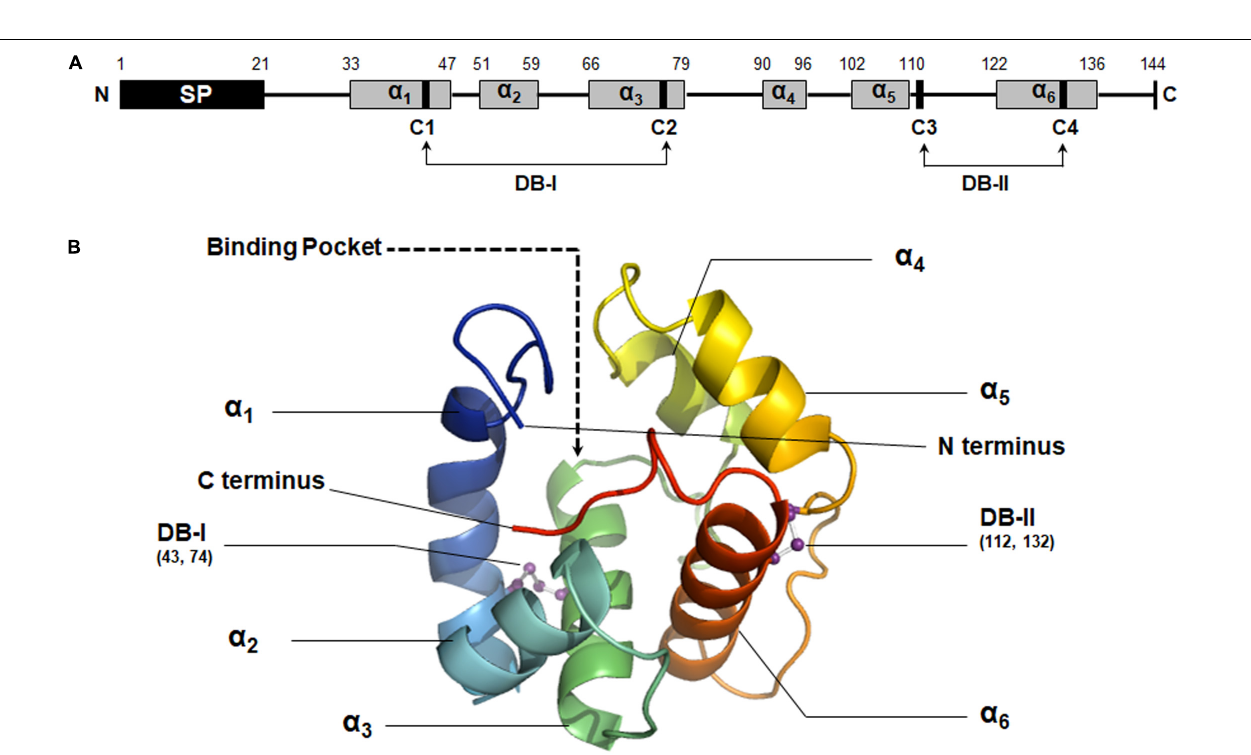
FIGURE 2 | Structural analysis of MaltOBP1. (A) The secondary structure of MaltOBP1. (B) The 3D structure of MaltOBP1. The six α -helices are labeled as α 1 – α 6 . DB-I, Disulfide bridge-I; DB-II, Disulfide bridge-II.